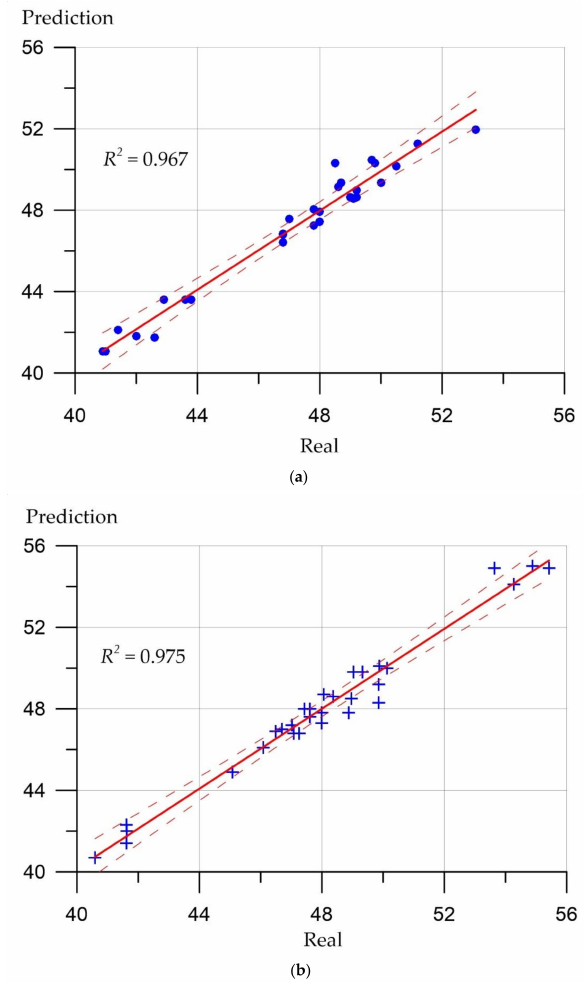
Figure 7. Correlation between real values of cubic compressive strength (MPa) and calculated values: ( a ) Deep neural network; ( b ) ensemble of regression